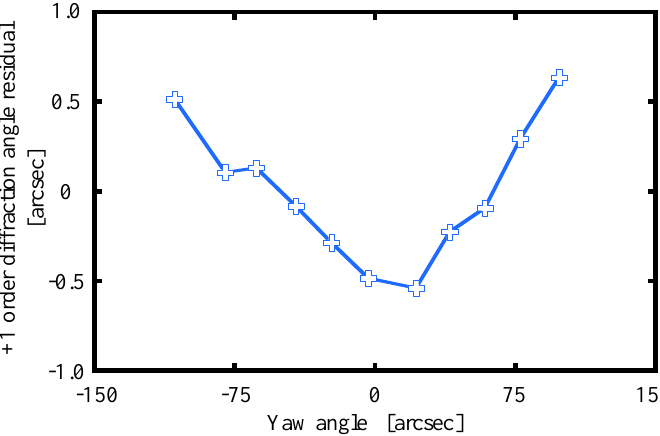
Figure 15. Calibration results of AC2 in the wavelength corrector kit.